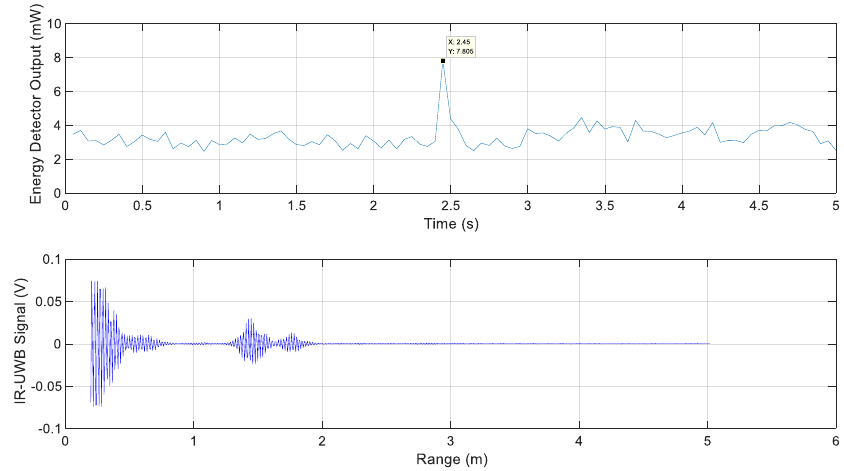
Figure 13. Energy detector output and IR-UWB signal for round manhole.